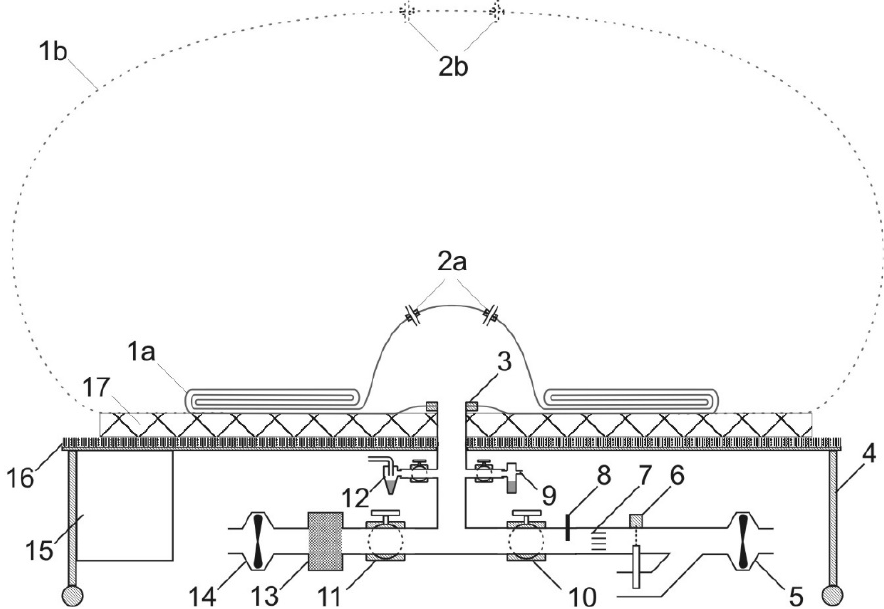
Figure 1. (1) Foil chamber (a: at the beginning of an experiment; b: fully inflated at the end of an experiment), (2) ports for different sensors (a: at the beginning of an experiment; b: fully inflated at the end of an experiment), (3) port for filling and emptying the chamber, (4) mobile measuring platform, (5) fan for filling, (6) stepper motor driven slide valve, (7) flow straightener, (8) hot wire anemometer, (9) bioaerosol generator, (10) ball valve, (11) ball valve 2, (12) bioaerosol collector, (13) HEPA filter (H14), (14) fan for draining, (15) measuring and control equipment, (16) artificial grass, and (17) spacer (wire mesh). (Figure created by author.)